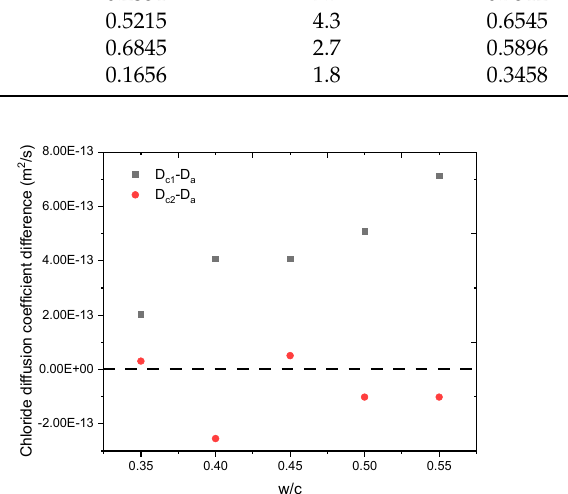
Figure 9. Chloride diffusion coefficient difference with NTB 355 and Truc methods (D c1 denotes the chloride diffusion coefficient determined by Truc method, linear regression was started from 24 h; D c2 denotes the chloride diffusion coefficient determined by Truc method, linear regression was started from 60 h; D a denotes the chloride diffusion coefficient determined by NTB 335 method).